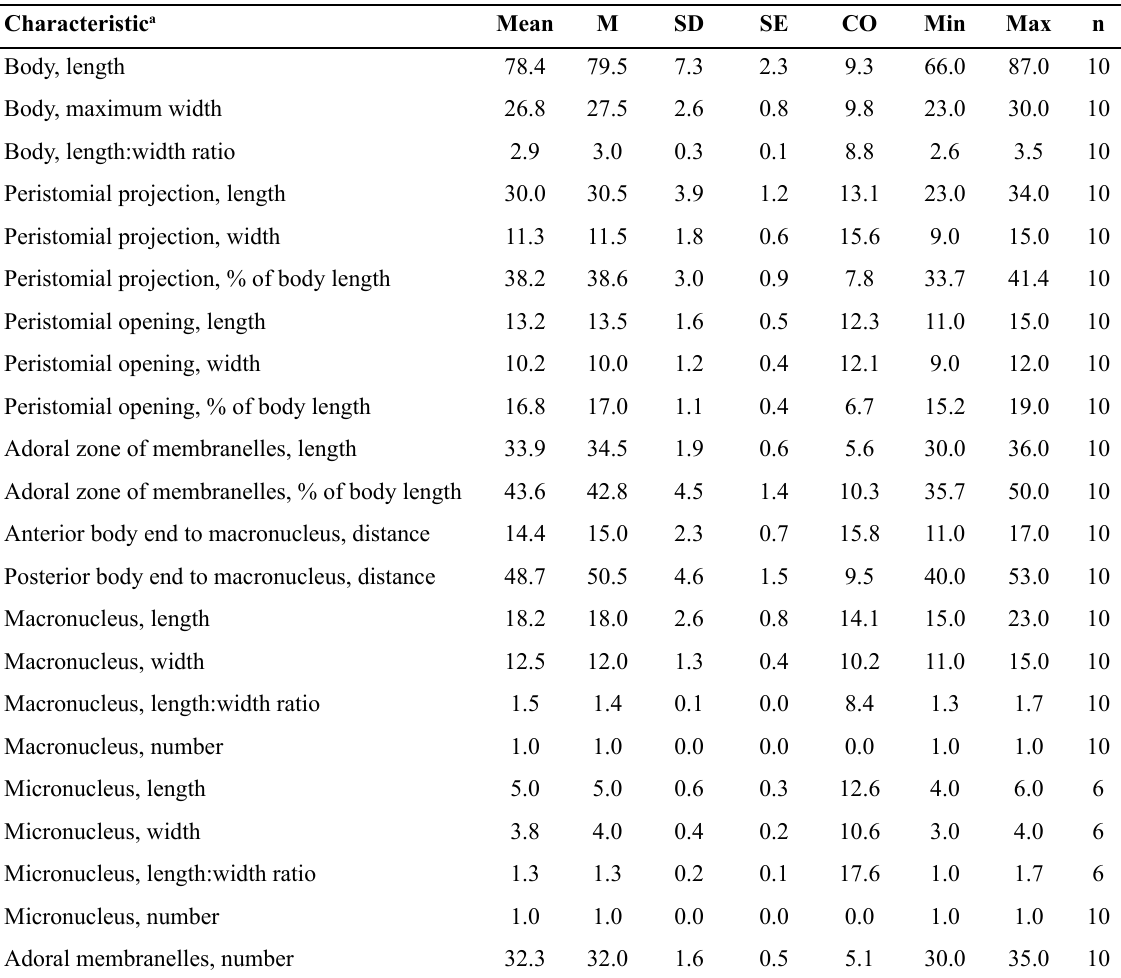
Table 2. Morphometric data on Clevelandella hastula (Kidder, 1937) from Vietnam. Characteristic a Mean M SD SE CO Body, length